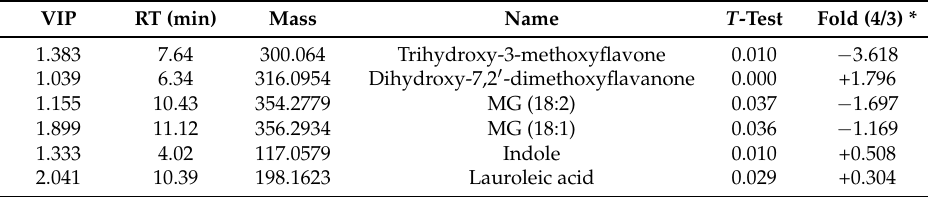
Table 5. The main identification obtained between 3 days and 4 days in ESI+ ( p <